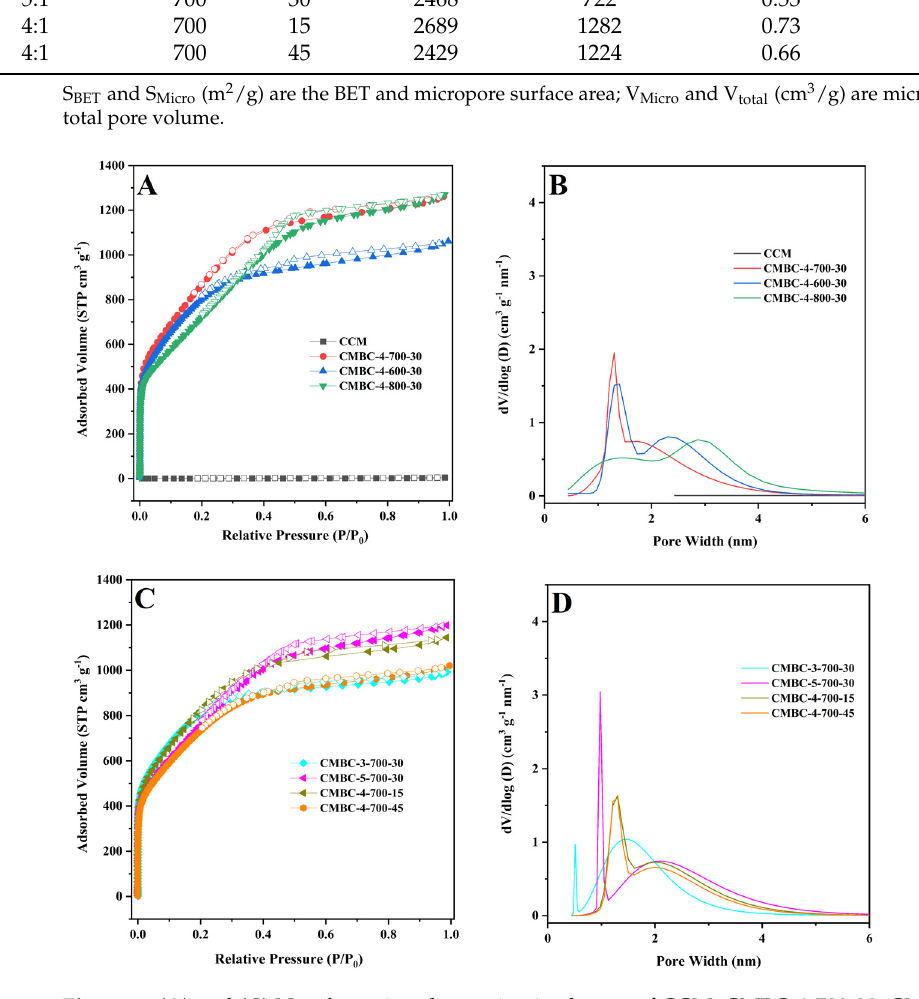
Figure 3. ( A ) and ( C ) N 2 adsorption-desorption isotherms of CCM, CMBC-4-700-30, CMBC-4-600-30, and CMBC-4 800-30, CMBC-3-700-30, CMBC-5-700-30, CMBC-4-700-15, and 267 CMBC-4-700-45 and ( B ) and ( D ) their pore size distribution.